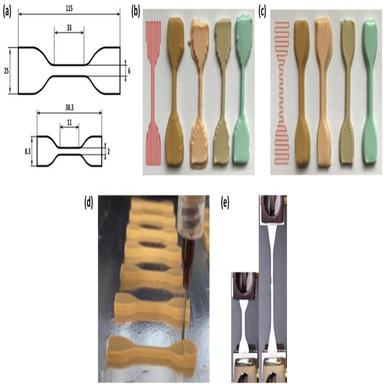
(a) Tensile test specimen dimensions used in this study: ASTM D412-C dimensions (top) and reduced dimensions (bottom) (not to scale). (b) Dogbone specimens printed longitudinally (PL) to the tensile direction. (c) Dogbone specimens printed transversally (PT) to the tensile direction. (d) Picture showing the direct ink writing of PT samples. (e) Tensile test images.